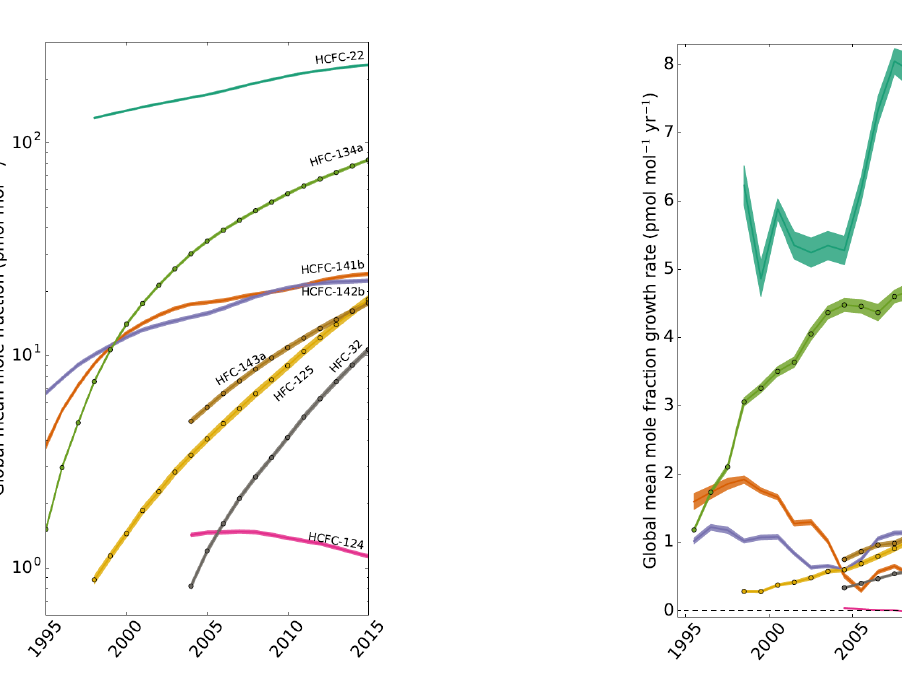
Figure 2. Average global mean mole fraction growth rates (pmolmol − 1 yr − 1 ) determined from the 12-box model for the HCFCs and HFCs. Note that for HCFC-124, HFC-143a and HFC- 32 we only use Medusa data for these calculations; for all others we use combined GC-MS-ADS and GC-MS-Medusa